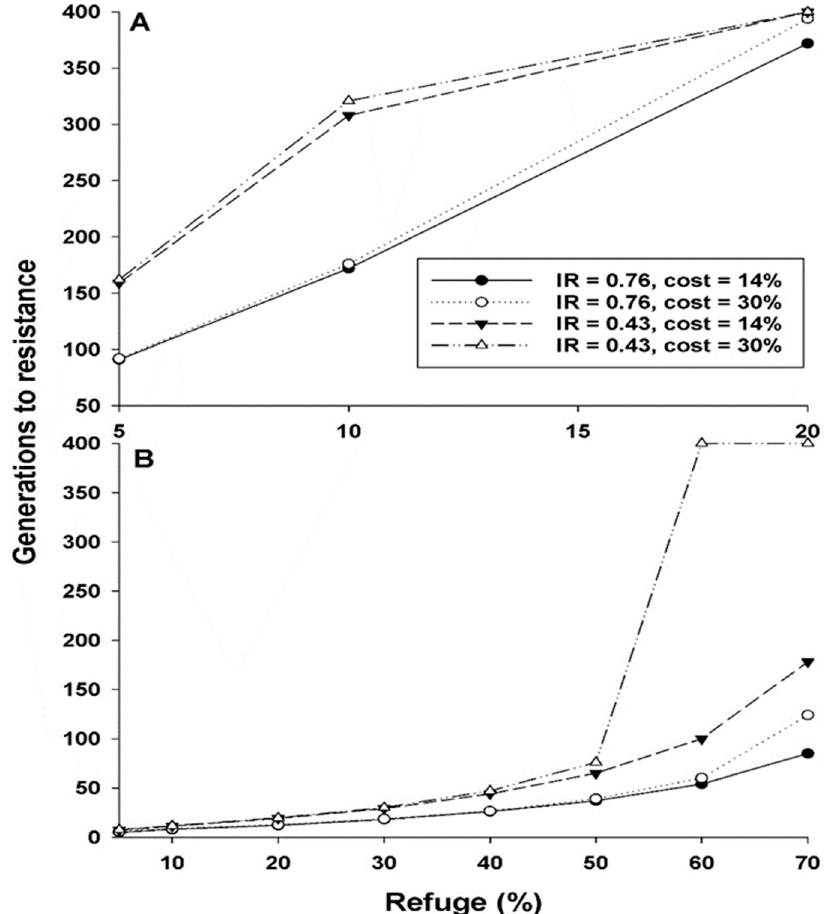
Figure 1. Effects of costs and incomplete resistance (IR) on evolution of resistance in simulations with ( A ) Recessive resistance ( h = 0) and ( B ) Nonrecessive resistance ( h = 0.26). Values for IR and costs correspond to observed means from cases with practical resistance (IR = 0.76, cost = 14%) and without practical resistance (IR = 0.43, cost = 30%). Generations to resistance are the generations for the resistance allele frequency to increase from the initial value of 0.001 to 0.50. Simulation runs were stopped if resistance allele frequency did not reach 0.50 after 400